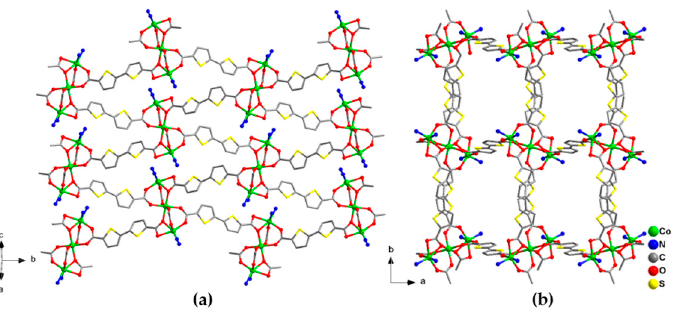
Figure 2. Projection of the crystal structure of 1 along different directions. Cobalt atoms are shown by green balls. Only N atoms of coordinated bpy ligands are shown. Hydrogen atoms and guest solvent molecules are omitted.